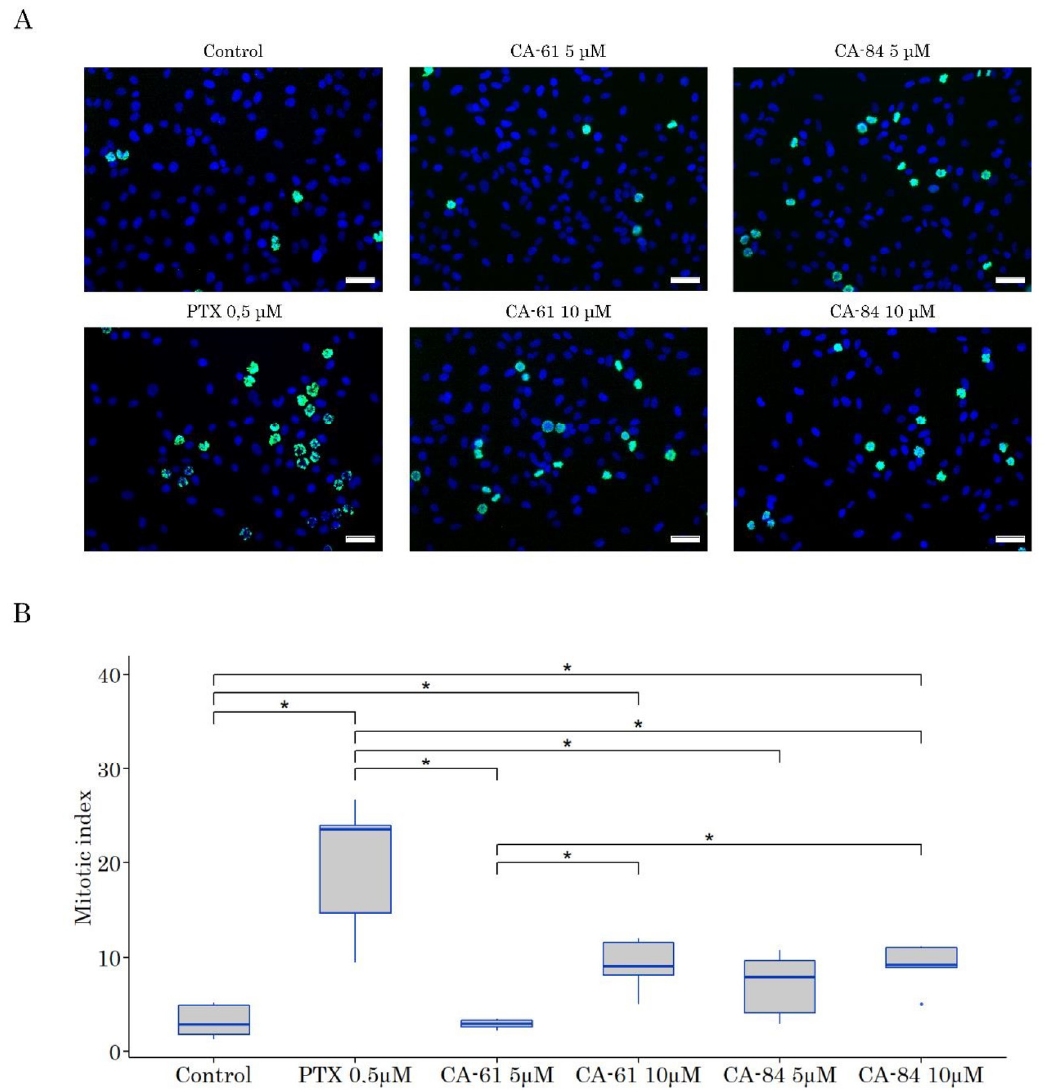
Figure 10. Accumulation of tumor cells in M-phase induced by CAs. ( A ) The representative images (20×) of HCC1806 cells immunostained by using Alexa488-conjugated anti-phospho-histone 3 (Ser10) antibody after incubation with DMSO (negative control), CA-61 (5 and 10 μ M), CA-84 (5 and 10 μ M) and Paclitaxel (PTX) (0.5 μ M, positive control). Cell nuclei were outlined by staining with DAPI. Magnification 20×, scale bars 50 μ M. ( B ) The plot representing the mitotic index calculated from 5 low-power fields for each experimental condition indicated above; * p < 0.05.